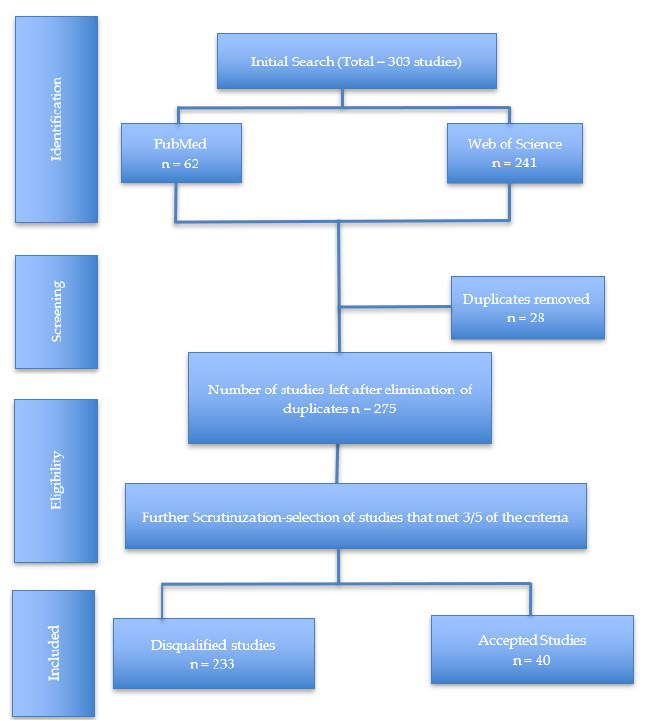
Figure 1. Selection of literature for review.